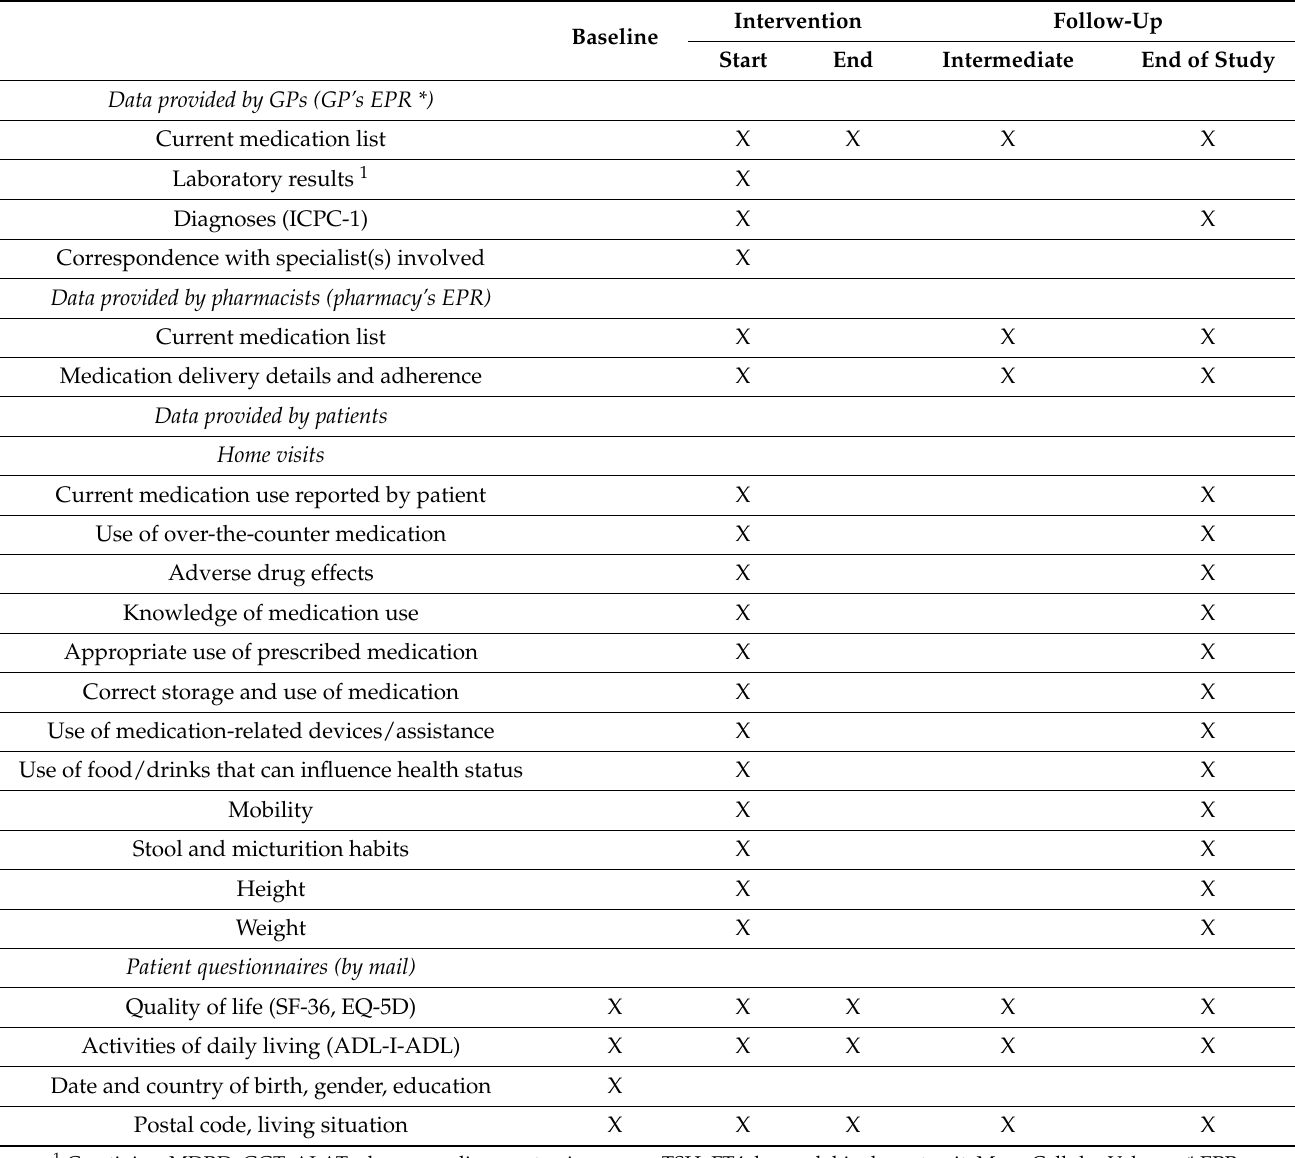
Table 1. Data collection: concepts measured at General Practice (GP), Pharmacy, and Patient for the Polypharmacy Intervention Limburg (PIL)